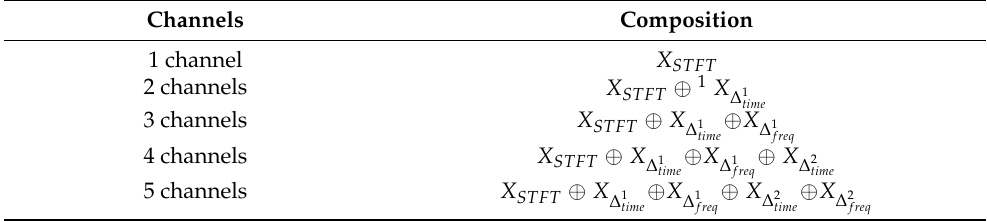
Table 1. Multi-channel time–frequency map